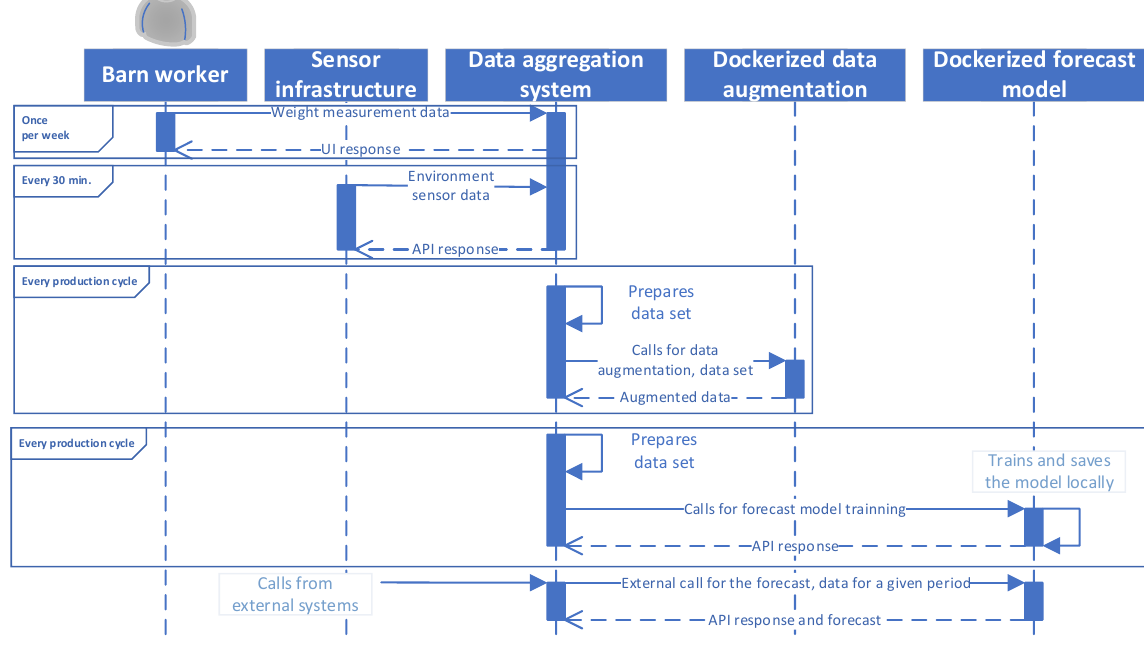
Figure 8 . Main steps of the data